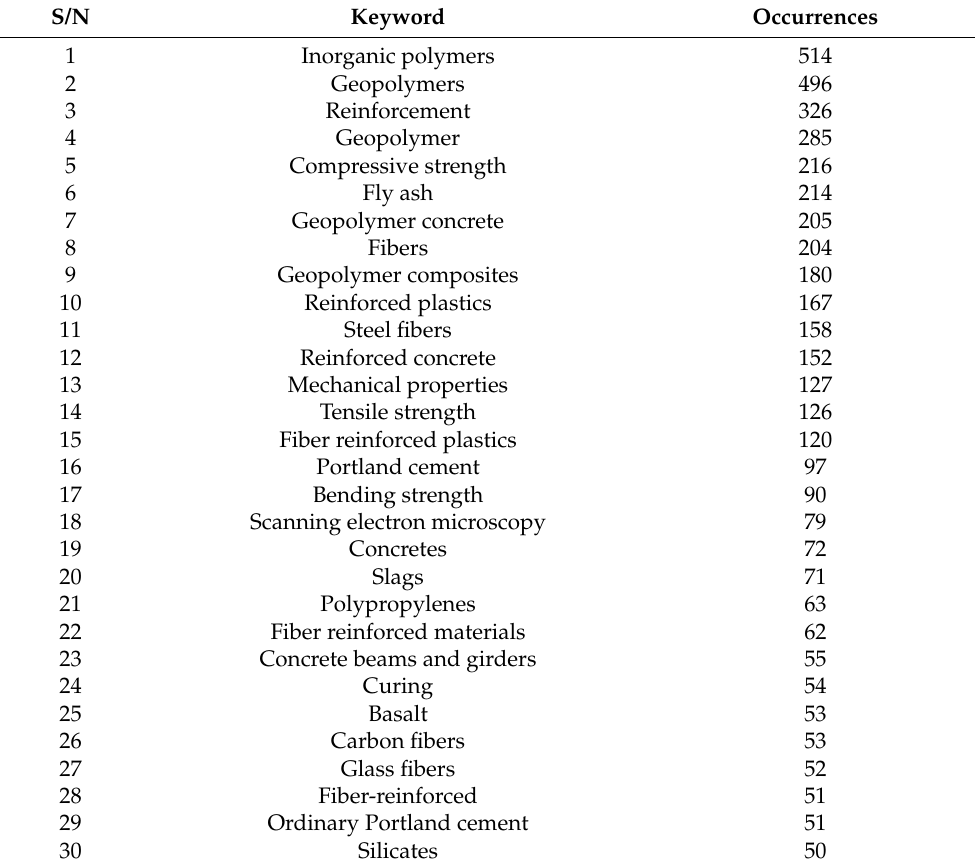
Table 2. List of 30 highly employed keywords in publications of FRGP